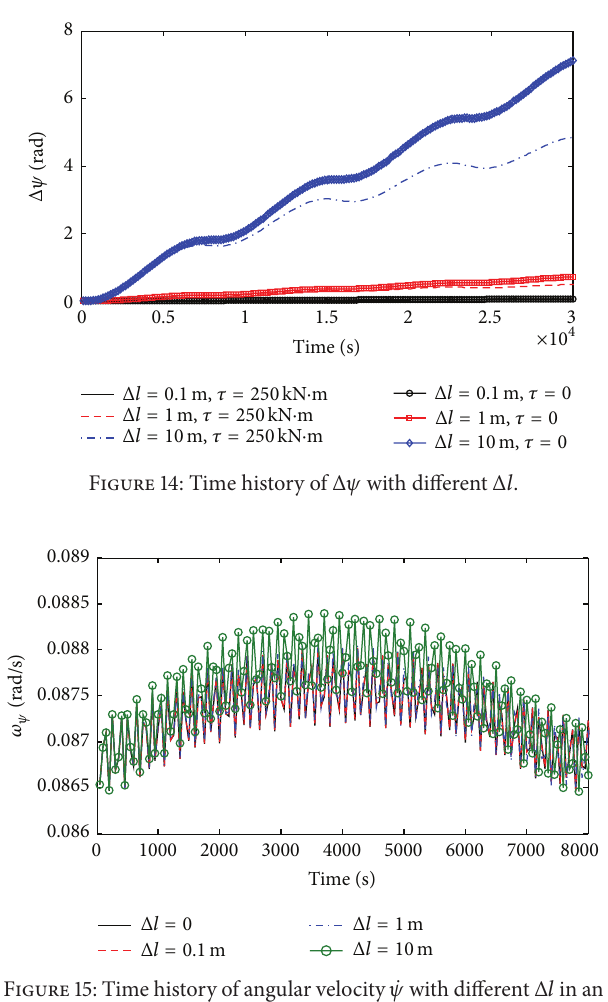
Figure 15: Time history of angular velocity ̇𝜓 with different Δ𝑙 in an orbit period, 𝜏 = 0 (simulation step = 50).